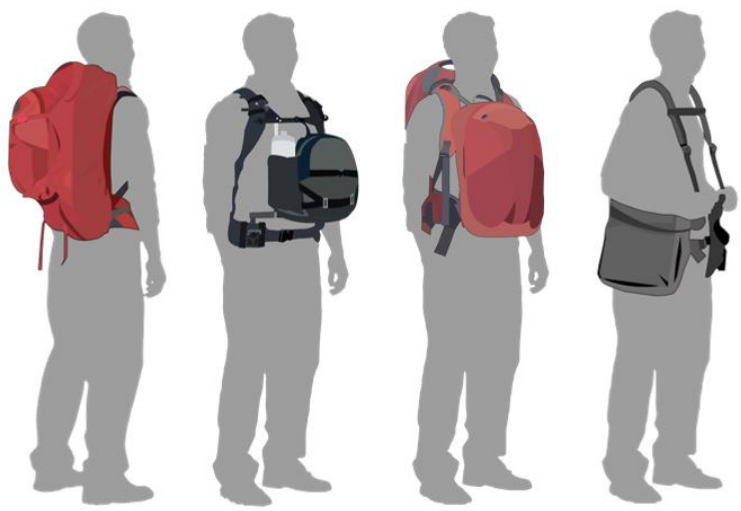
Figure 1. From left to right: backpack, front pack, double pack and T-pack. The reviewed articles analyzed the effects of different load carrying systems on (1) biomechanical, (2) physiological, (3) muscle activity, (4) comfort and (5) performance